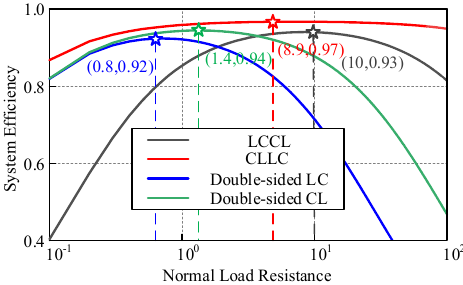
Figure 14. System efficiency versus load resistance variations.